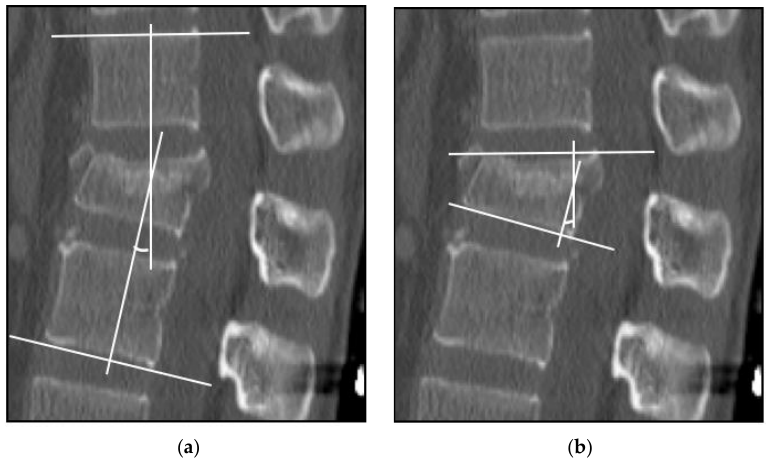
Figure 1. ( a ) Local kyphosis angle. ( b ) Wedge-shaped deformation angle.